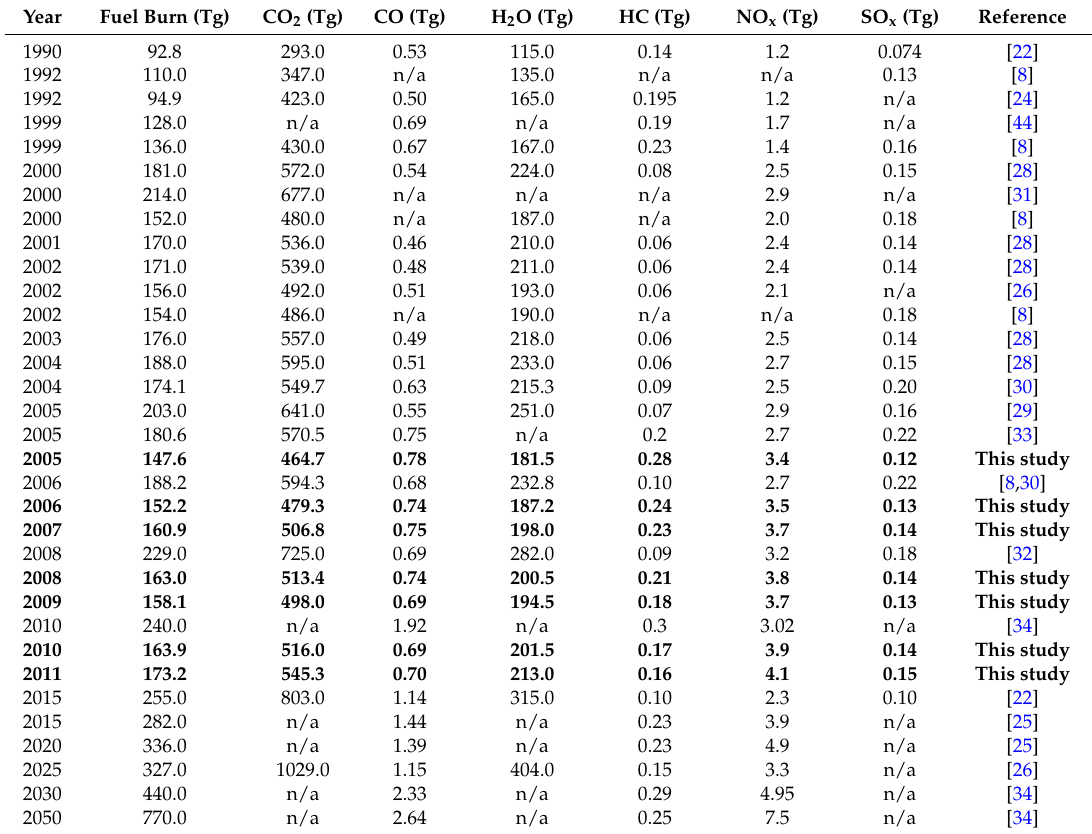
Table 2. Global annual fuel burn and aircraft CO 2 , CO, H 2 O, HC, NO x and SO x emissions in this study and their comparison with previous